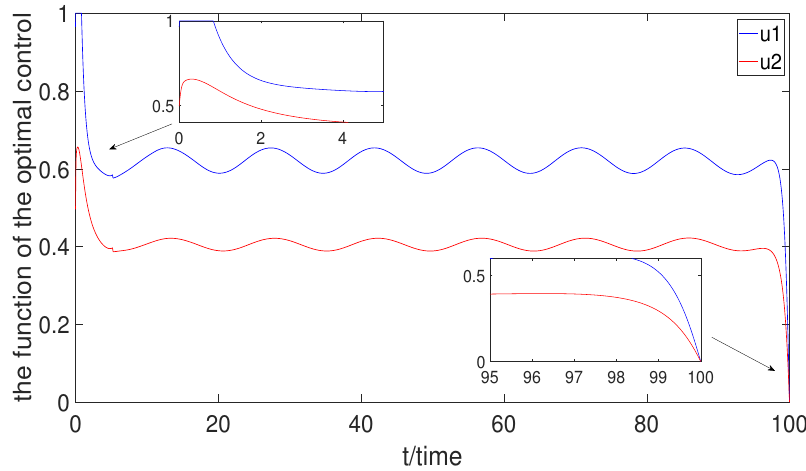
Figure 9. The optimal control curves when τ = 5.2. When τ = 2.2, Figure 10 shows the ratio of different nodes for four control cases.